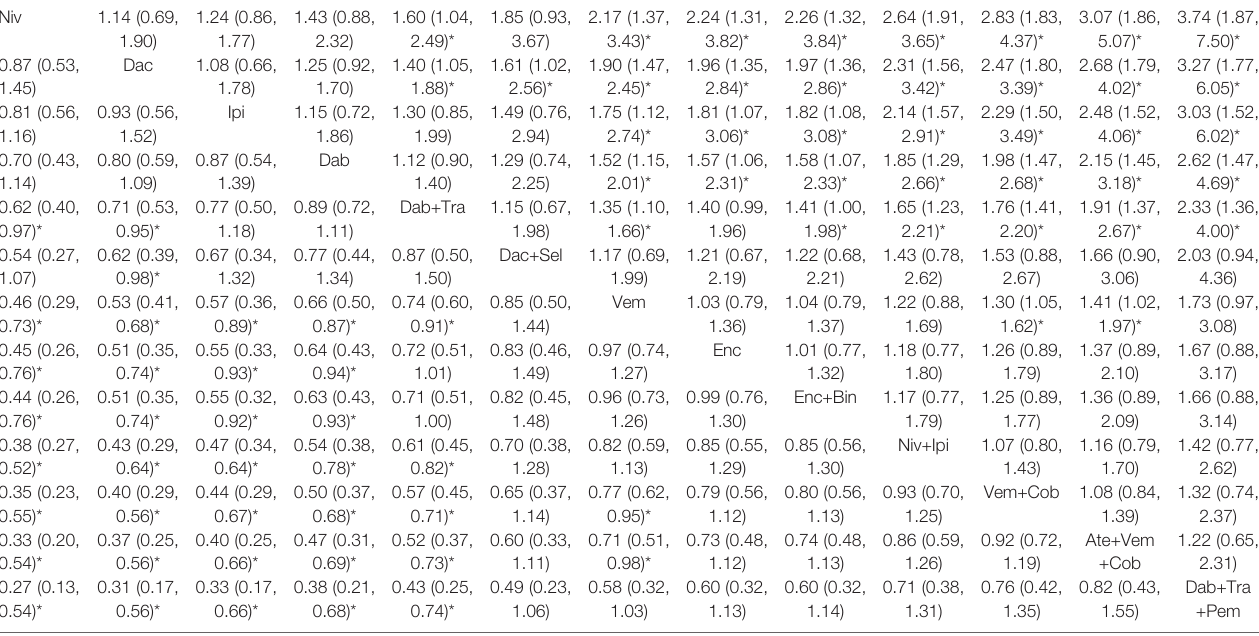
TABLE 3 | Head-to-head comparisons for acceptability of severe